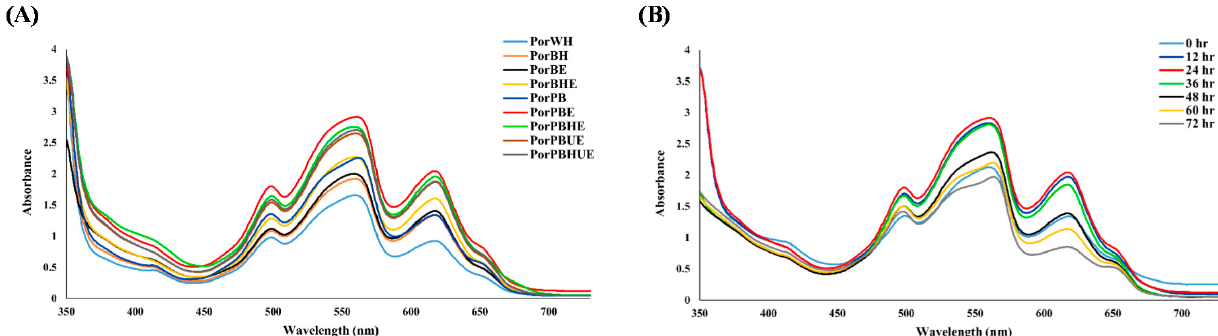
Figure 1. The pH value and enzyme activity of crude enzymes solution during incubation period of P. vesicularis MA 103 ( A ) and A. salmonicida MAEF108 ( B ) induced with MMB- Porphyra media. Each value is mean ± standard deviation ( n = 3). Comparison of activity of the same enzyme at different time, * and ** indicate significantly different at p < 0.05 and p < 0.01, respectively.